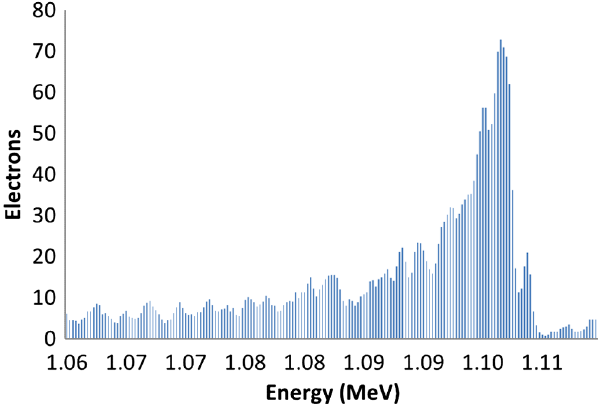
FIG. 10. Energy spectrum of the beam at the cavity output from